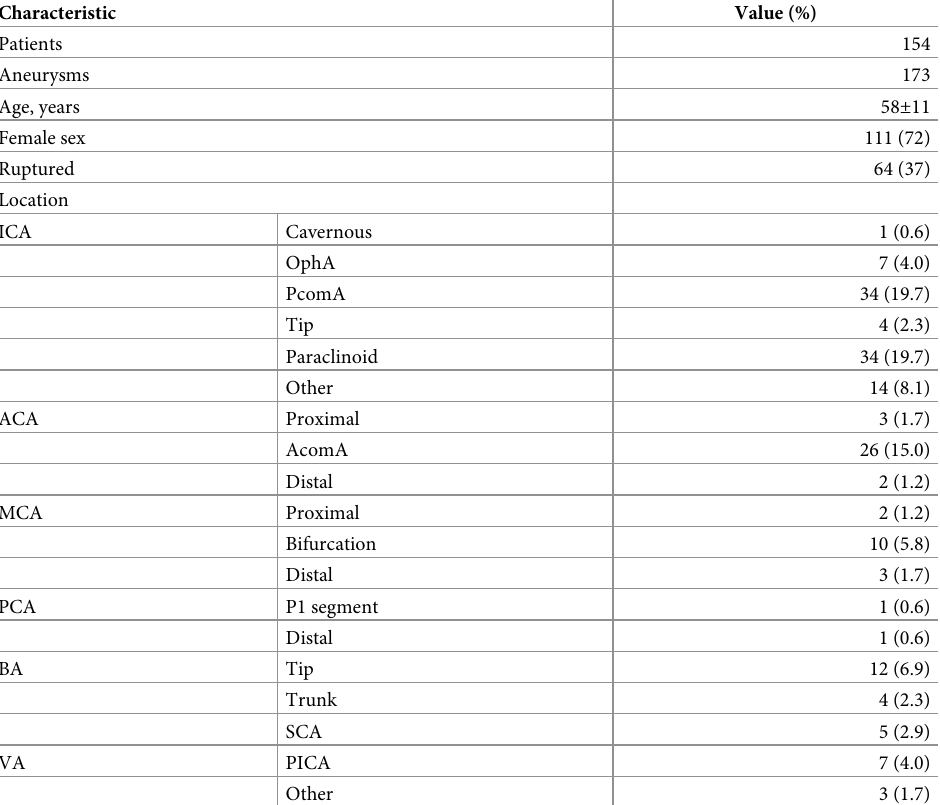
Table 1. Characteristics of patients and aneurysms treated with endovascular